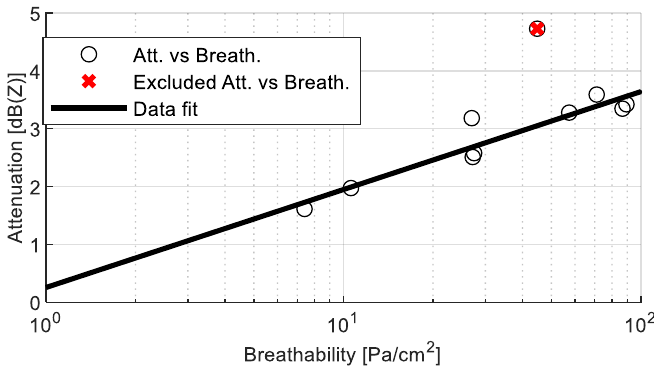
Figure 17. Correlation between acoustic attenuation and the logarithm of breathability (R 2 = 0.9).